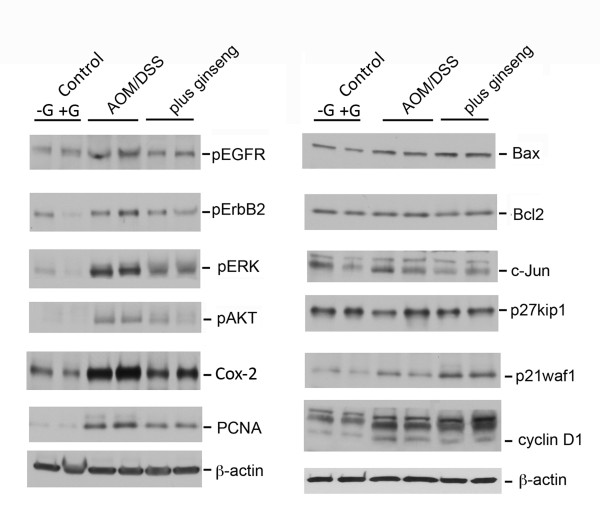
Ginseng inhibits EGFR signals and Cox-2 up-regulation and increases pro-apoptotic Bax in AOM/DSS tumors. Control mucosa (-G, Western diet alone, +G, Western diet + ginseng) and colonic tumors were homogenized in Laemmli buffer and indicated proteins detected by Western blotting. Shown are representative control samples and tumors from each group. Quantitative densitometry is provided in Table 2.